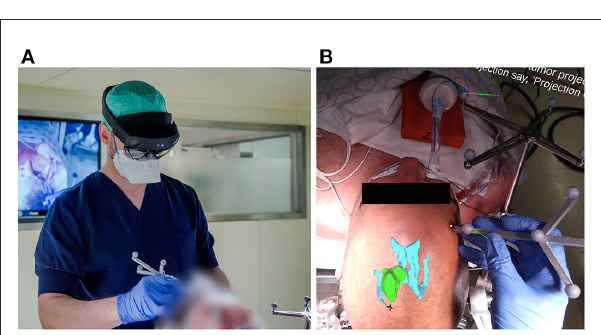
FIGURE2 (A) Investigator wearing the AR headset and performing the planning step with the AR application for guidance, using an in-house designed handheld stylus and a stationary reference star, adopted from the Brainlab Curve neuronavigation system. (B) View from within the AR headset, as seen by the investigator at the moment after patient registration and before tumor projection and delineation. The AR overlay shows the 3D tumor and ventricle models in their correct anatomical position. The black cross marked on the patient’s skin indicates the central entry point, as predefined by the experienced neurosurgeon. The RGB axes visible on the Brainlab reference star indicate the established 3D cartesian coordinate system in which the patient’s position is being tracked. The RGB axes visible on the handheld stylus indicate its correct tracking, along with the white dot aligned on its tooltip.